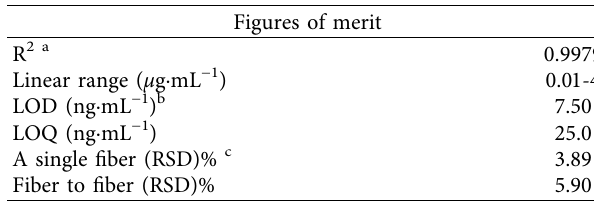
a Square of correlation coefficient. b Limit of detection ( n � 20). c